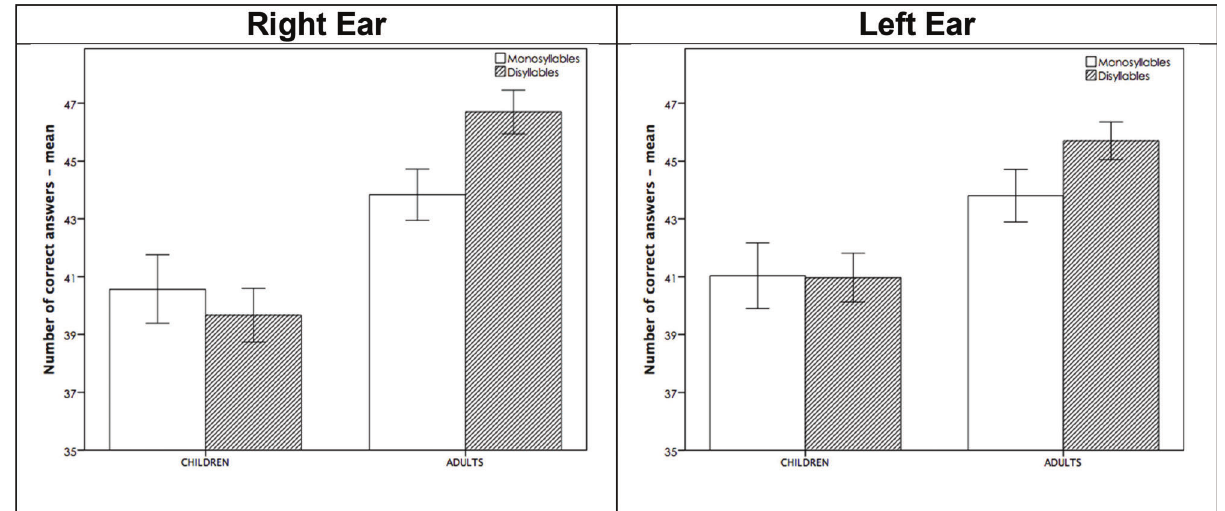
Figure 2 - Mean performance among the monosyllable and disyllabic modalities in TCS, in both ears, in the groups of children and